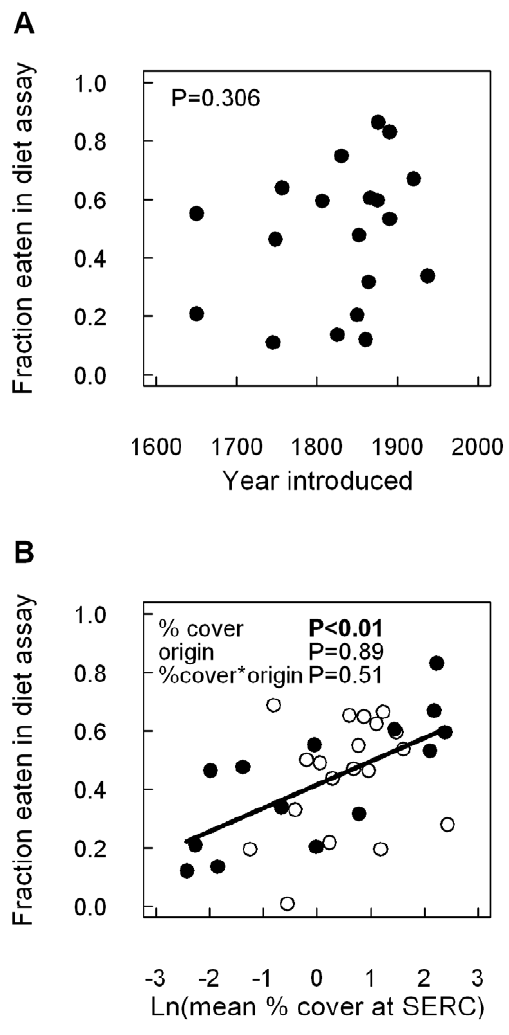
Figure 2. Local abundance, but not time since introduction, predicts native herbivore preference for extracted exotic plant chemistry. Relationship between leaf extract consumption and (A) date of introduction and (B) local plant abundance. There was no relationship between the earliest recorded date of introduction and extract deterrence to a native herbivore (A). However, plant species with deterrent secondary chemistry were the least abundant species in forest understory communities (B), a pattern that held across both native and exotic species (non-significant origin*abundance interac- tion). Filled circles represent exotic species; open circles represent native species.